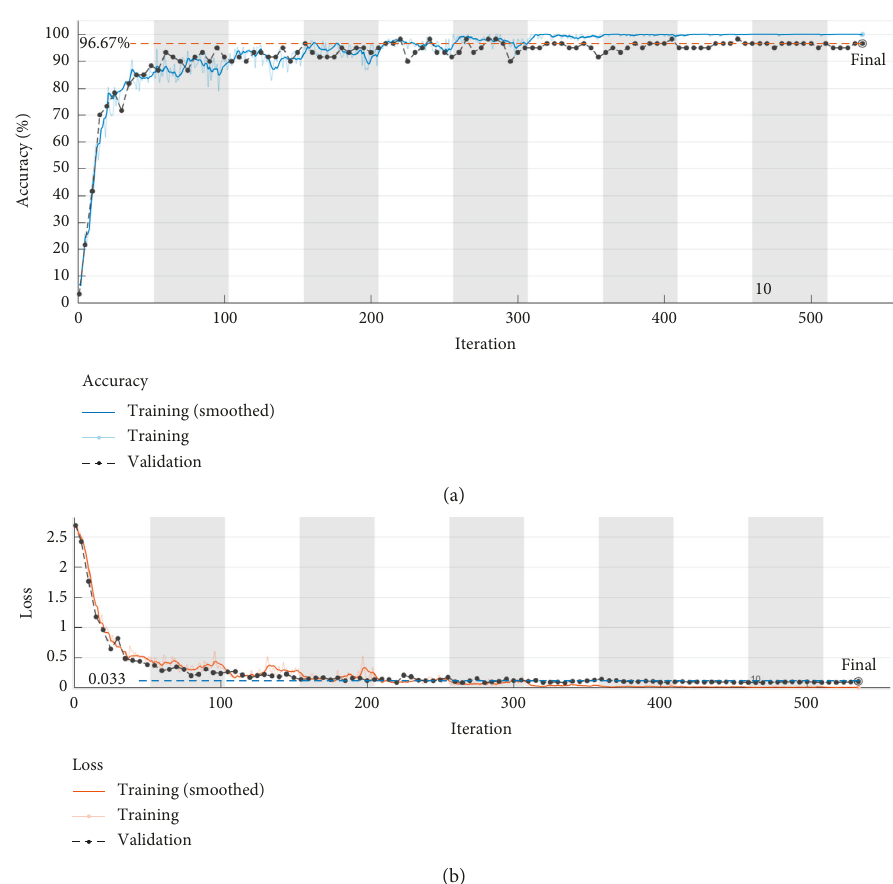
Figure 7: (a) Training CNN with optimized calculated value reached 97% accuracy after 10 epochs. (b) Loss function output during training, the error value is 0.033 after passing 10 epochs.